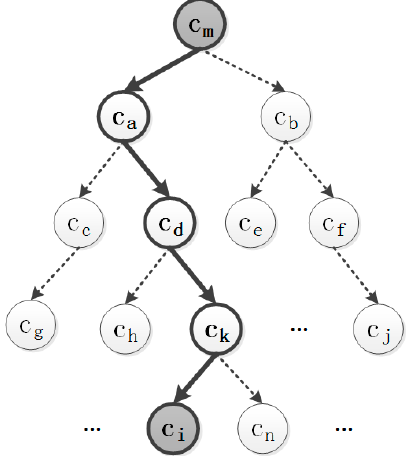
Figure 2. The path of the object character in the context of the Huffman tree. c a to c n is the characters in the document ordered by the frequency. c m is the root character and c i is the target character. The black path with direction is the way to calculate the probability of target character c i